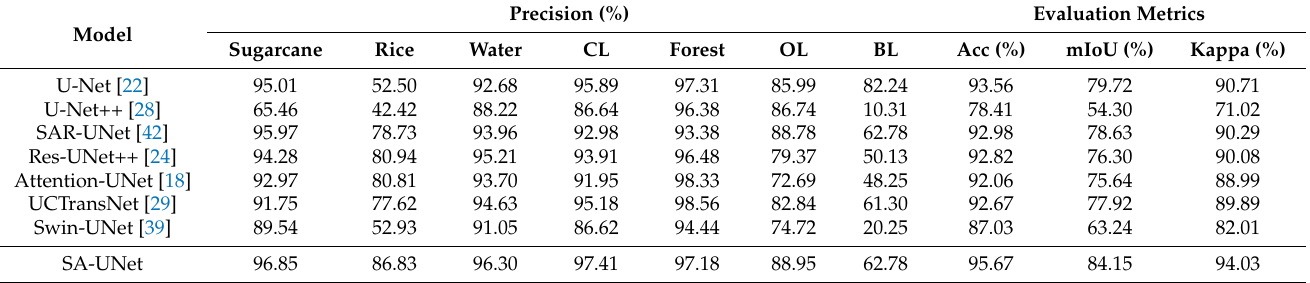
Table 8. Comparison of segmentation results of test sets in the 2017 dataset I by different methods. Model